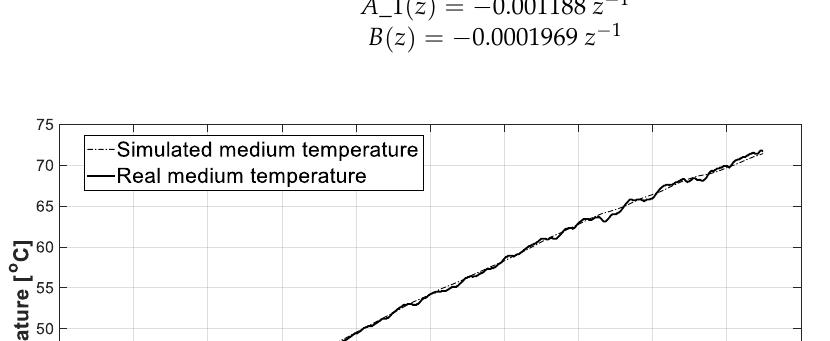
Figure 7. Operating data for inlet and outlet temperatures of the medium and water in the storage tank.